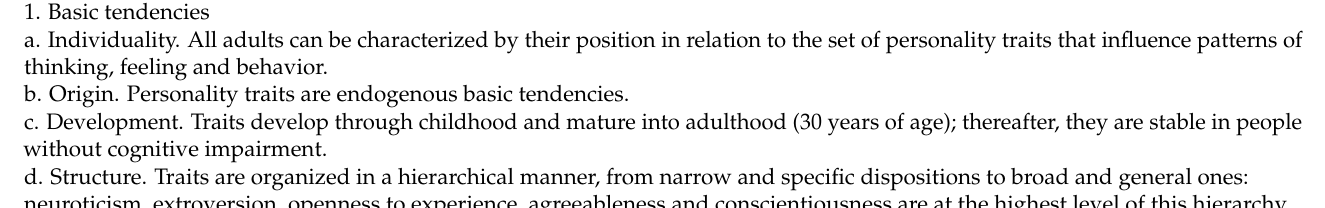
Table 1. The main postulates of five factor